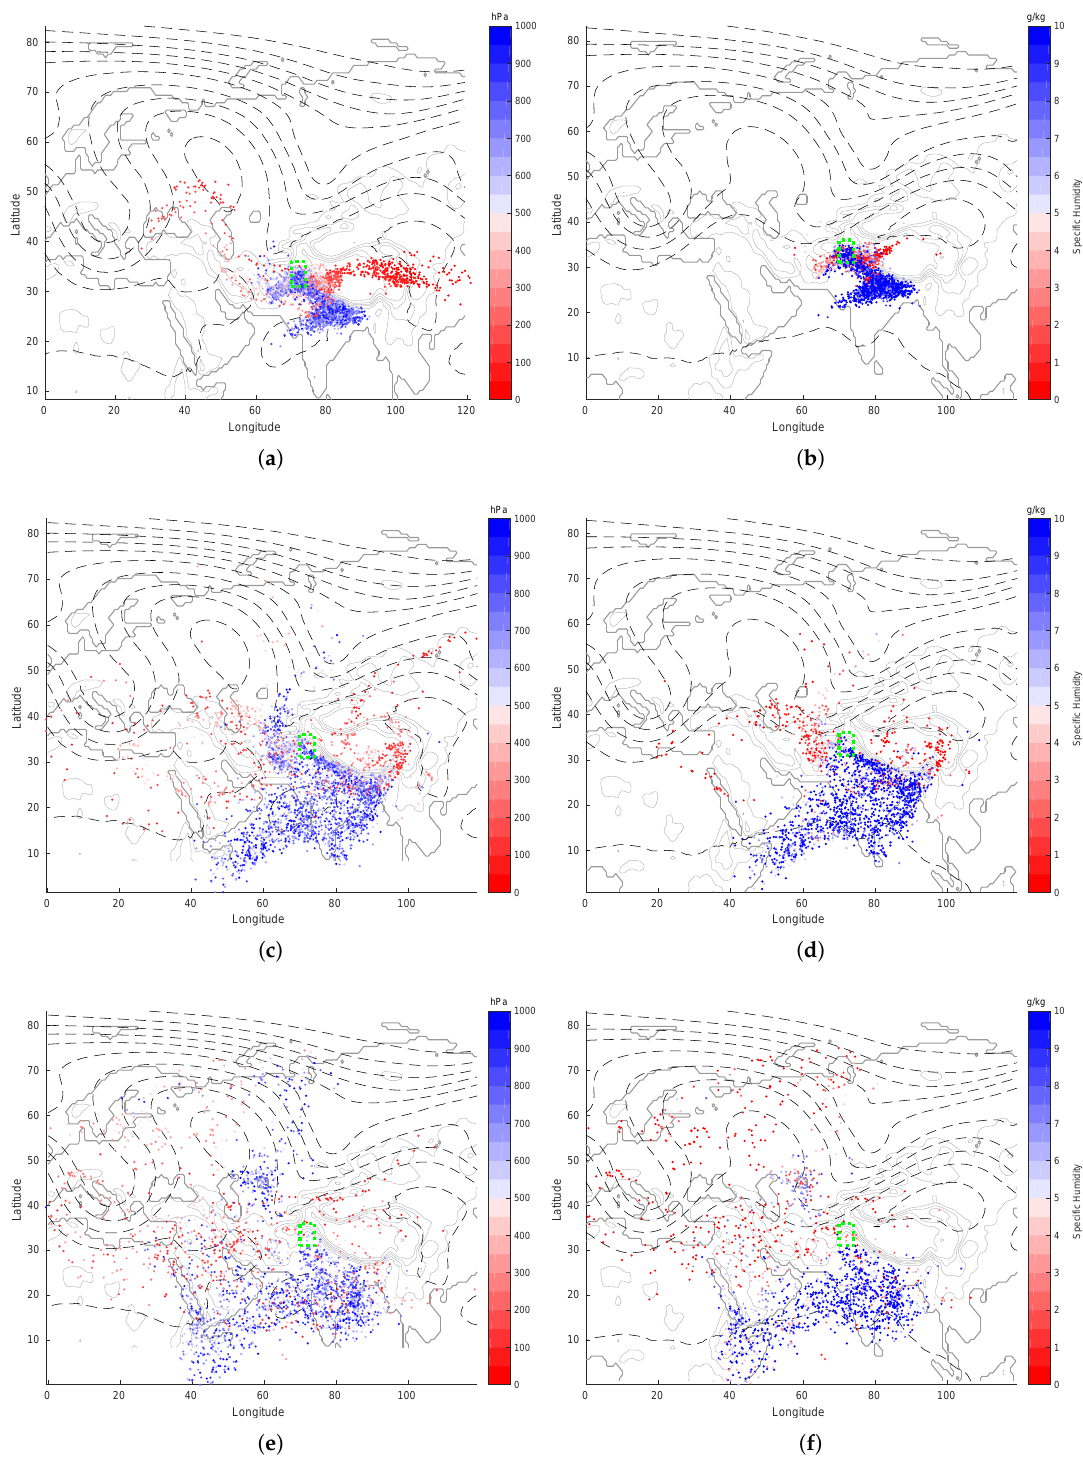
Figure 11. All back-trajectories emanating from NP on 28 July 2010. ( a ) parcel pressure, 2 days back in time, along the parcel trajectory; ( b ) parcel pressure, 2 days back in time, along the parcel trajectory; ( c ) parcel pressure, 6 days back in time, along the parcel trajectory; ( d ) specific humidity, 6 days back in time, along the parcel trajectory; ( e ) specific humidity, 10 days back in time, along the parcel trajectory; ( f ) specific humidity, 10 days back in time, along the parcel trajectory. The dashed lines indicate the 5 and 2 day means of 500 mb geopotential height for the left and right columns,